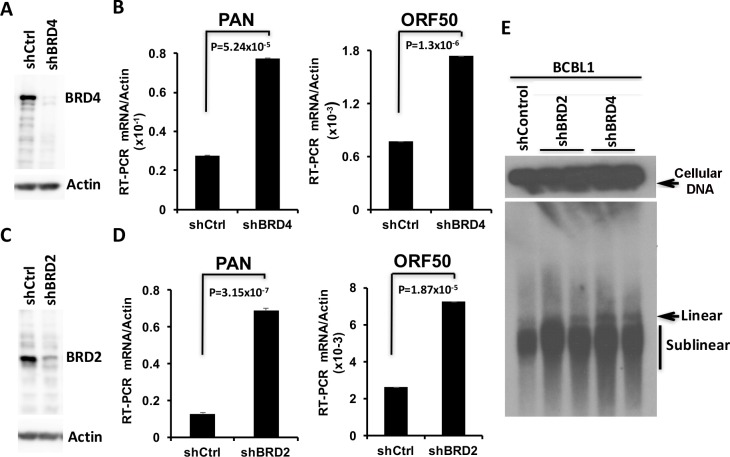
Depletion of BRD2 or BRD4 activates KSHV lytic cycle.(A) Western blot of BCBL1 cells transduced with shControl (shCtrl) or shBRD4, probed for BRD4 (top) or Actin (bottom). (B) RT-qPCR for PAN and ORF50 relative to actin in BCBL1 cells transduced with shCtrl or shBRD4. (C) Western blot of BCBL1 cells transduced with shCtrl or shBRD2 probed for BRD2 (top) or Actin (bottom). (D) RT-qPCR for PAN and ORF50 relative to actin in BCBL1 cells transduced with shCtrl or shBRD2. (E) PFGE analysis of BCBL1 cells transduced with shCtrl, shBRD2 (in duplicate), or shBDR4 (in duplicate) as indicated, and assayed by Southern blot with KSHV genome probe.